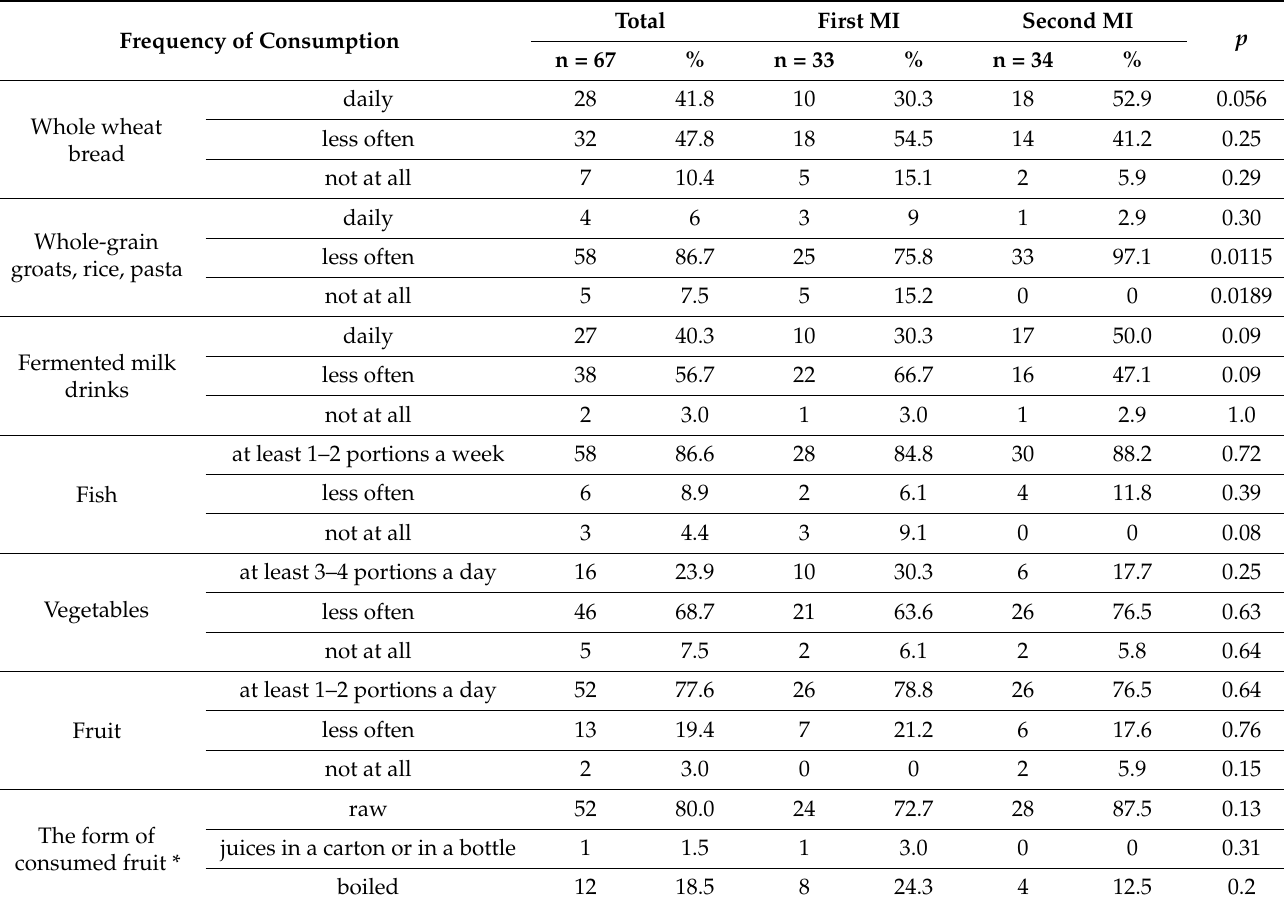
Table 3. The frequency of consuming food products recommended in the study group of patients, in total and by MI history (n = 67). * 65 people answered this question.